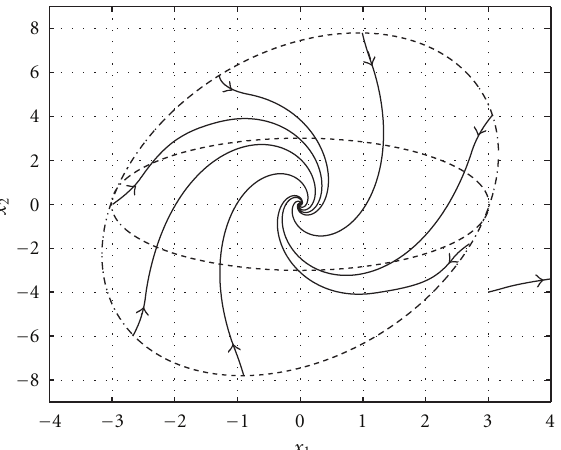
Figure 2: Trajectories and estimated domain of attraction for a maximum delay of h m = 0 .